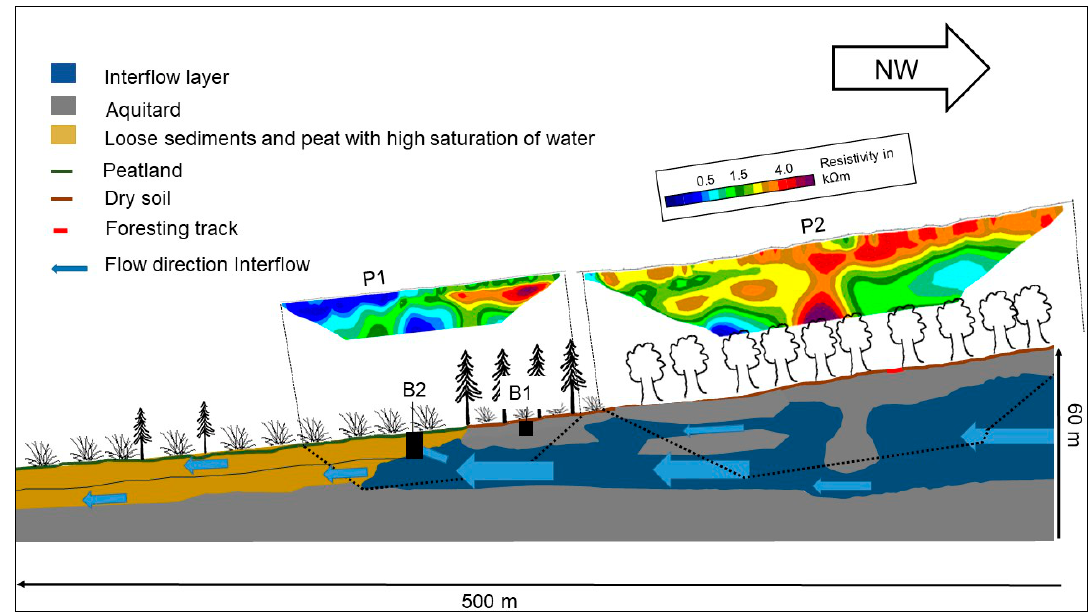
Figure 12. Model1: catchment area and wet part of "Thranenbruch".